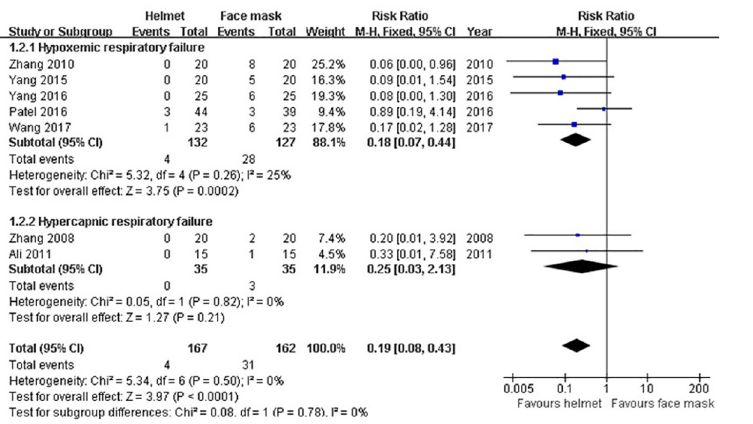
Fig 5. Forest plot of facial skin ulcer.